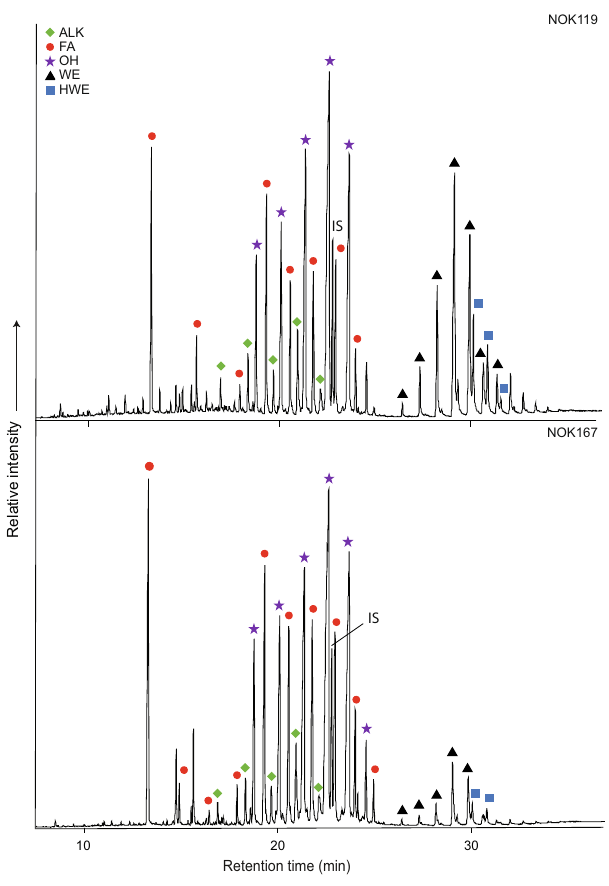
Fig. 4 High-temperature gas chromatograms showing beeswax lipid distributions. Partial high-temperature gas chromatograms of trimethylsilylated TLEs from Nok pottery extracts NOK119 and NOK167, red circles, n -alkanoic acids (fatty acids, FA); green rhombus, n -alkanes (ALK); purple star, n -alkanols (OH); black triangles, fatty acyl monoesters (WE); blue squares, hydroxyl fatty acyl monoesters (HWE) and IS internal standard, C 34 n -tetratriacontane.